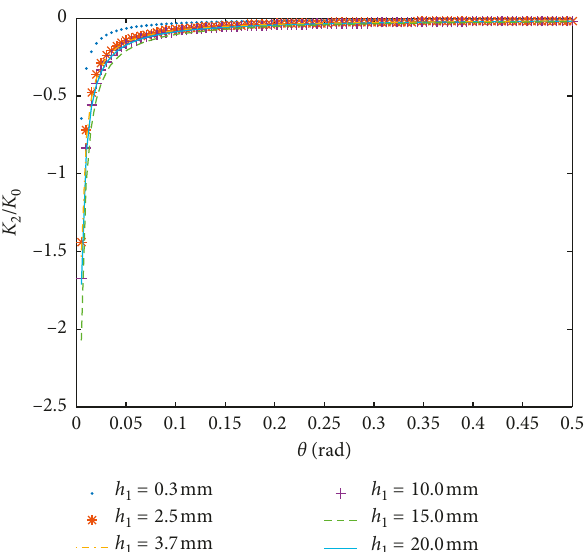
Figure 16: Relationship between IFs K values of parameter h